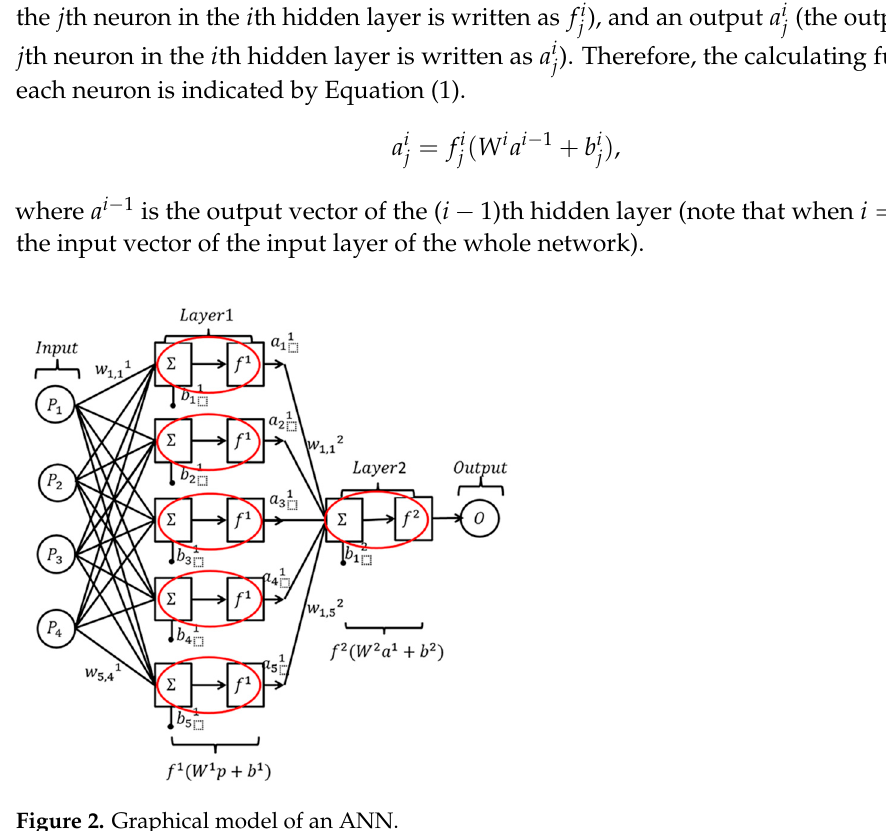
Figure 2. Graphical model of an ANN.